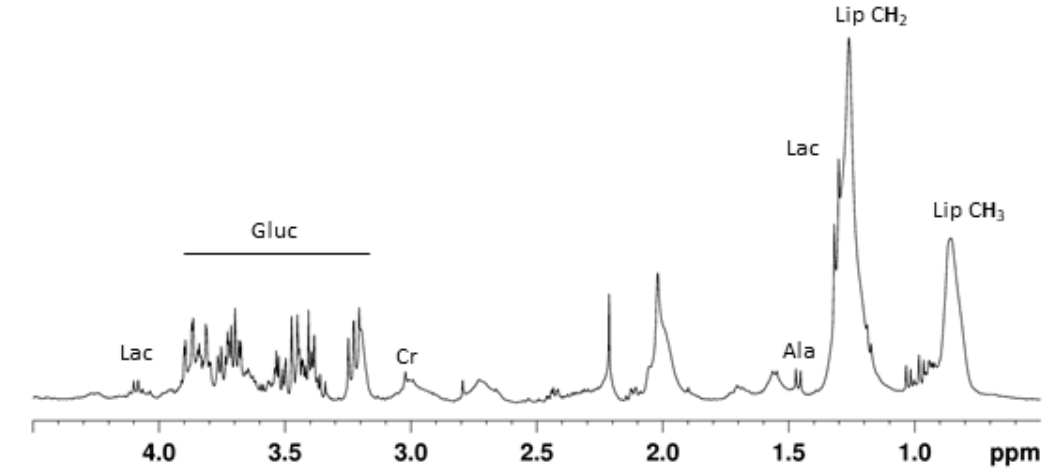
Figure 1. Typical 1 H NMR spectra of serum from the acute phase of TKS. The spectrum was acquired using a CPMG pulse sequence with an effective T2 delay of 32 ms. Lac—lactate; Gluc—glucose; Cr—creatine, Ala—alanine; Lip CH 2 —lipid methylene moieties; and Lip CH 3 —lipid methyl moieties.